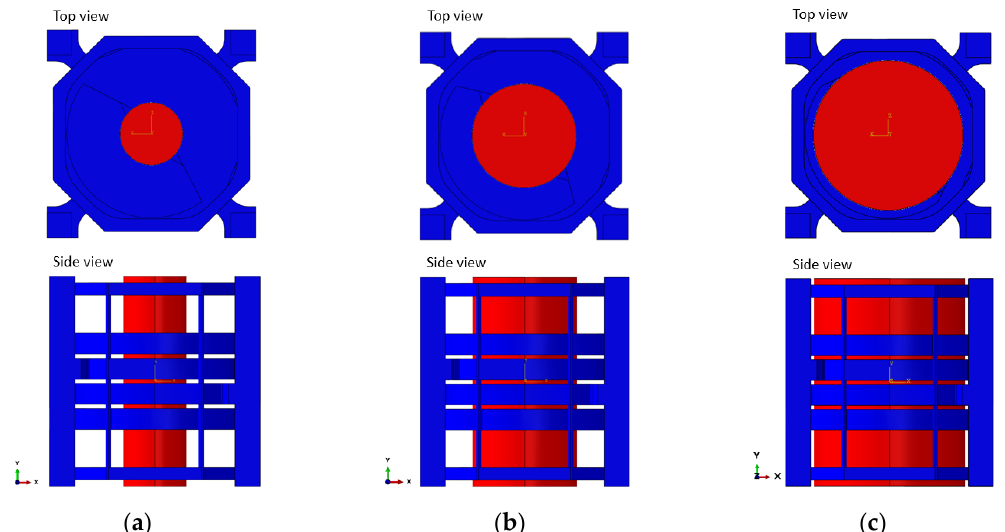
Figure 8. Illustration of the top view and the side view of ( a ) the (𝐷 𝐿) = 0.30⁄ model; ( b ) the (𝐷 𝐿) = 0.50⁄ model; and ( c ) the (𝐷 𝐿) = 0.73⁄ model.